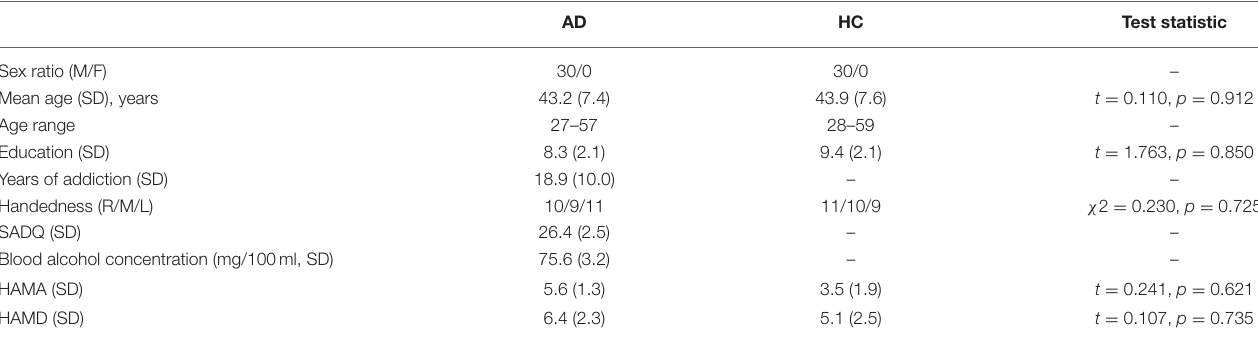
TABLE 1 | Demographic and clinical characteristics of participants.